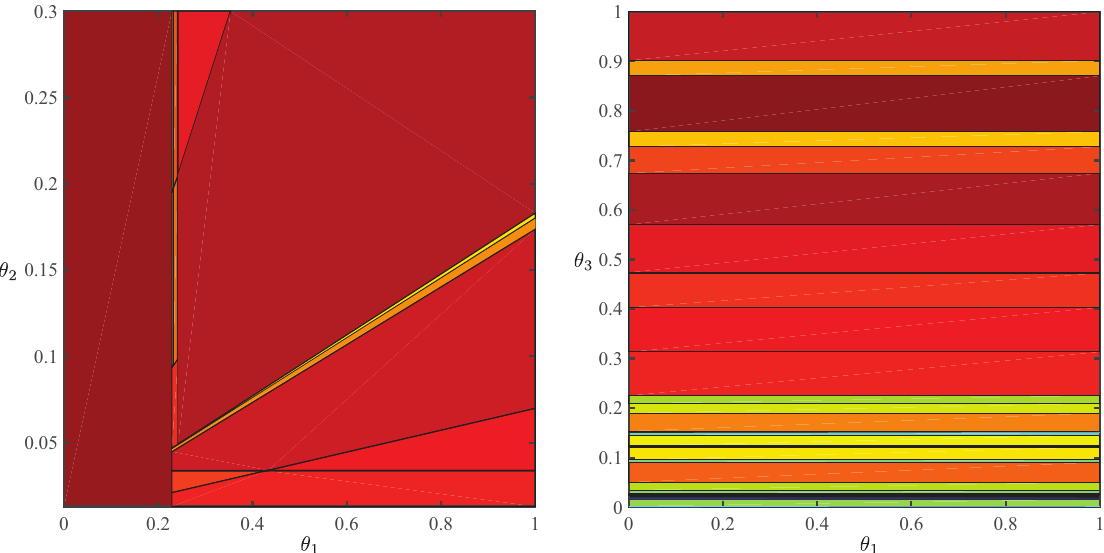
Figure 5. Polyhedral partitions of the parameter space for a genome-scale model of C. reinhardtii (iRC1080) [33] based on autotrophic (left panel) and heterotrophic (right panel) maximum-growth objectives and an auxiliary objective with an equivalent cost vector that furnishes a continuous parametric solution with respect to all decision variables [44]. Here, θ 1 = − v lb v eq p / v max, p , and θ 3 = − v lb / v max,O measure, respectively, the maximum uptake rate of carbon dioxide, O 2 2 photon flux, and maximum uptake rate of